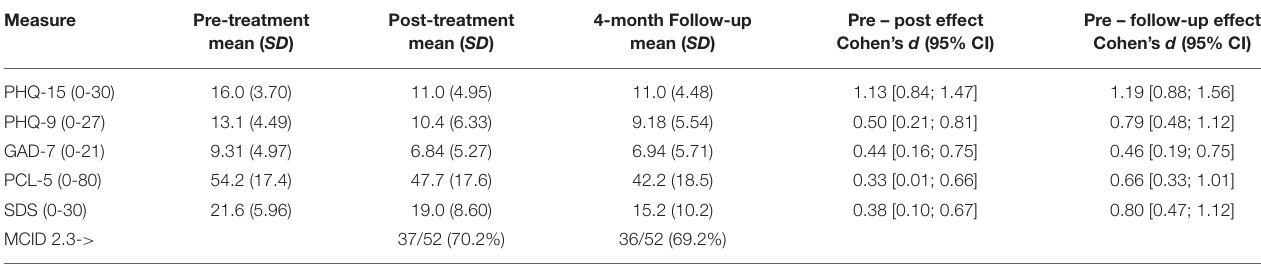
TABLE 6 | Means, SDs, effect sizes (Cohen’s d), and MCID for outcomes across assessment times.